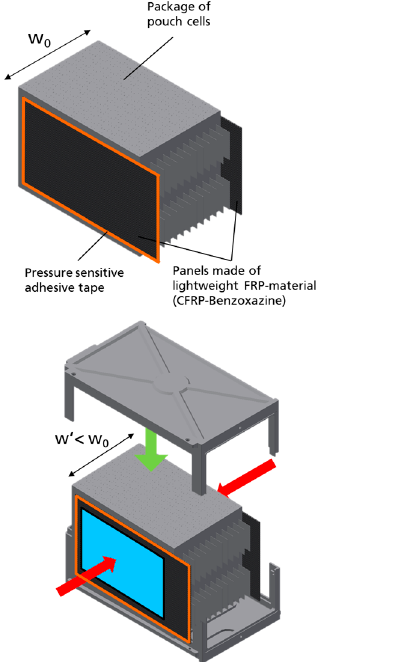
Figure 7. Load case “internal pressure as a result of swelling of the punch cell stack during loading”. The device used to join the side panels with the two battery module housing parts is shown in Figure 8 on the left. A joined battery module is shown in the figure on the right. Figure 9 shows the assembly process of the demonstrator modules. The finally assembled battery module can be seen in Figure 10.